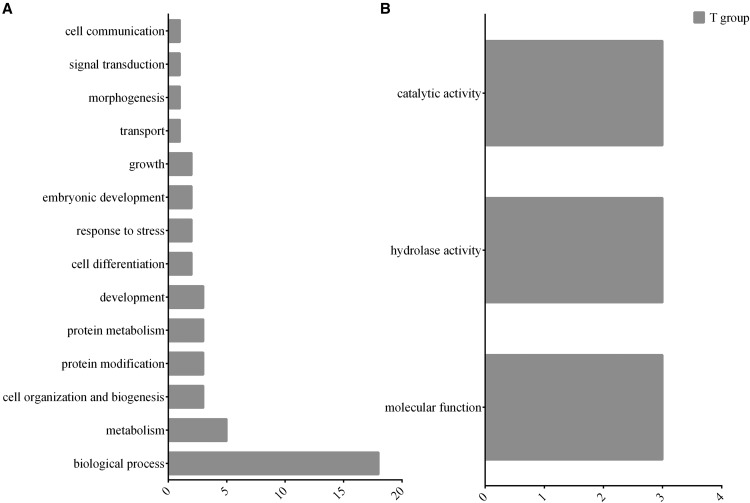
Representation of DE genes in the gene ontology (GO) classes for each ontology for T-treated fish at 60 min post-injection: A. Biological Process and B. Molecular Function. Enriched GO terms were obtained for downregulated transcripts and mapped to a total of 127 GO slim ancestor terms with CateGOrizer.